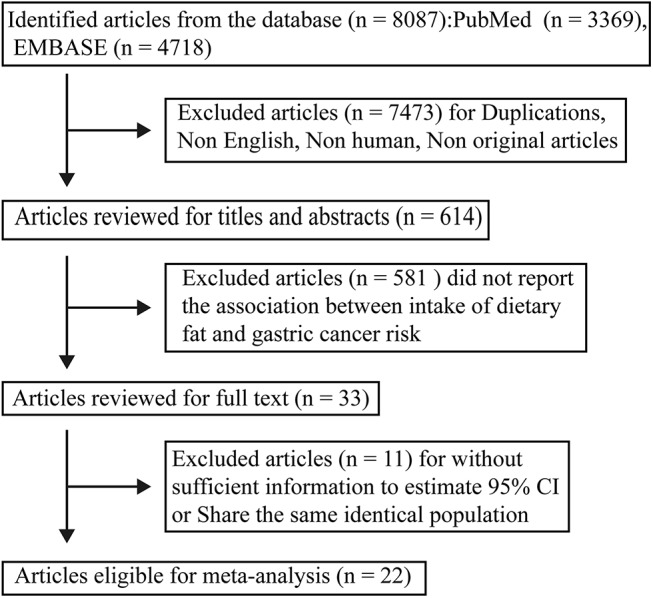
Flow chart of study selection.